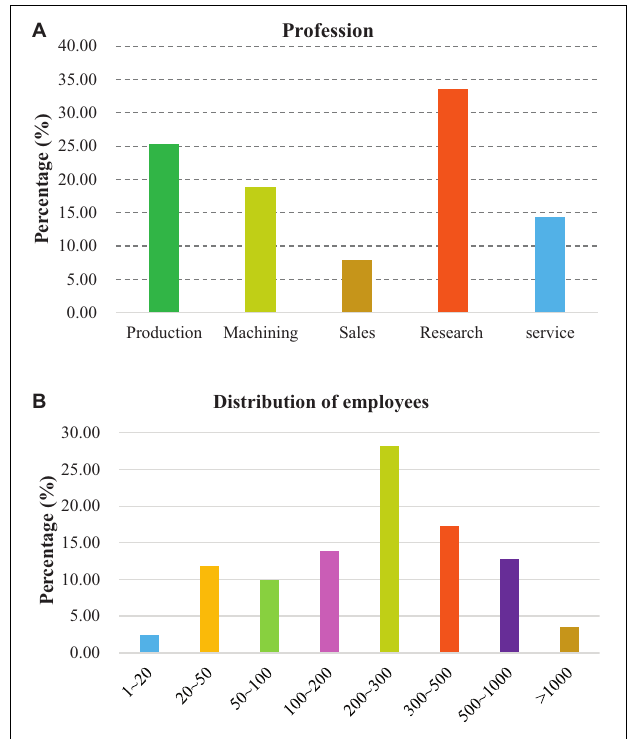
FIGURE 4 | The belonging industry and number of employees. (A) The belonging industry; (B) Employee distribution.